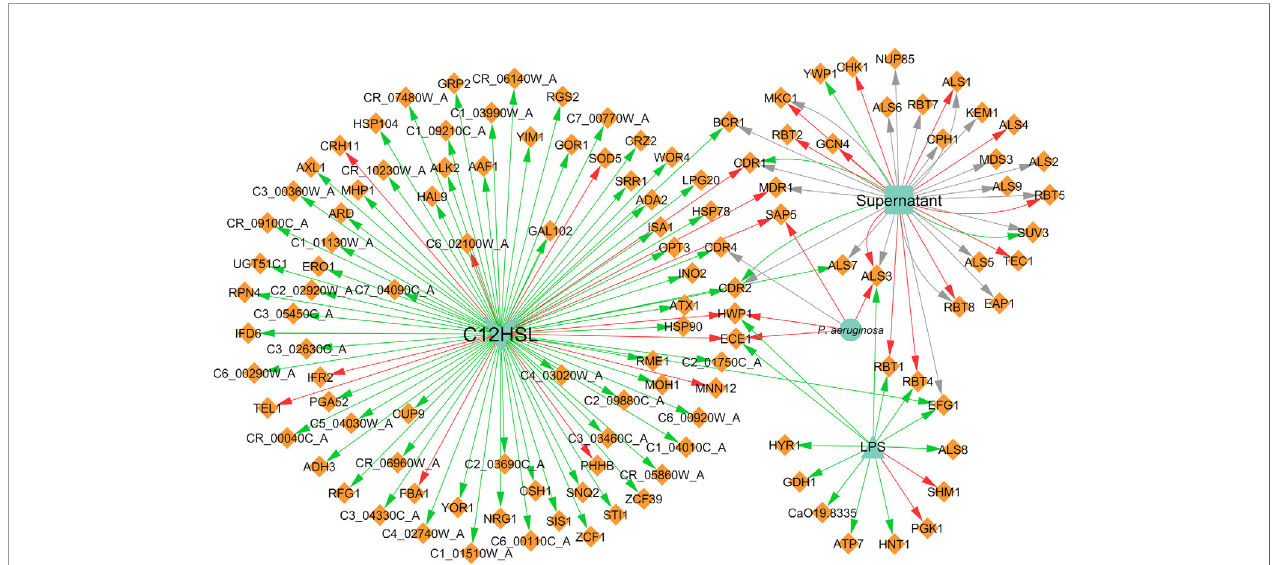
FIGURE 6 | Network of the effects of P. aeruginosa on C. albicans gene expression. Legend: Teal nodes, P. aeruginosa ; orange nodes, C. albicans ; green arrows, upregulation; grey arrows, null effect; red arrows: downregulation; node and node label sizes are directly proportional to the number of related (outward and inward) edges